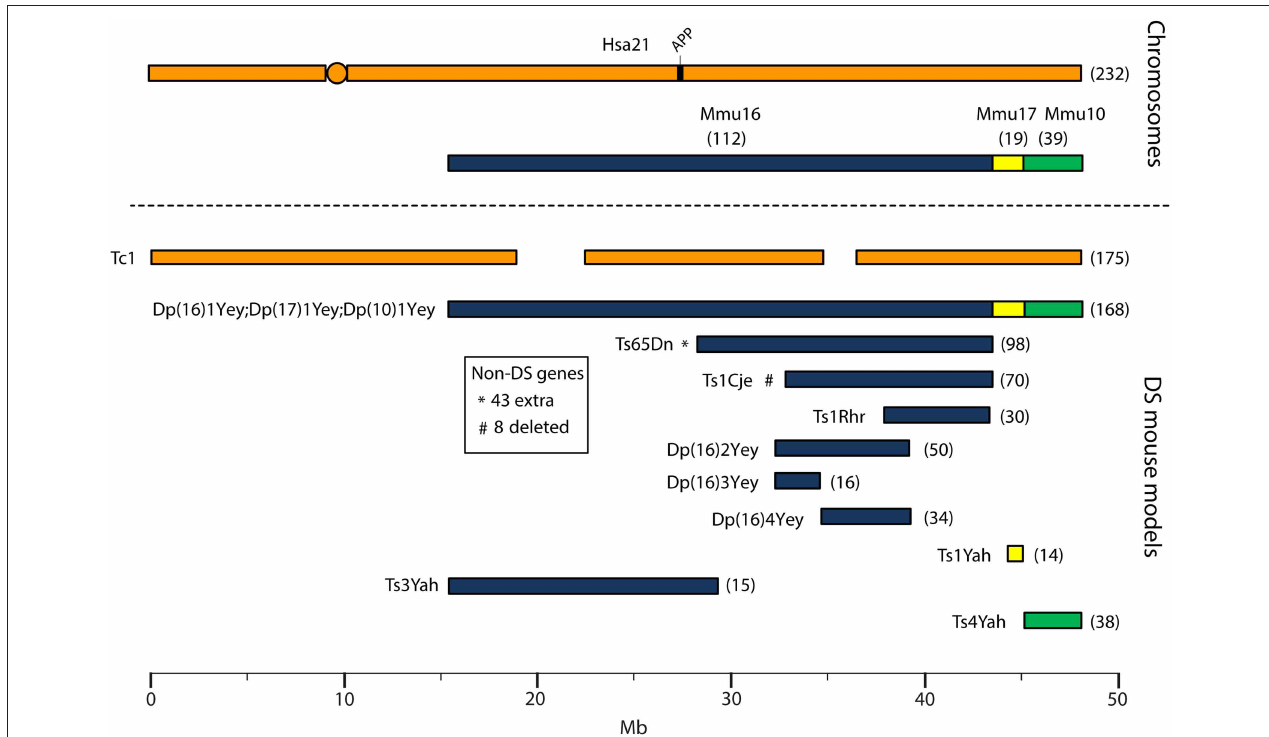
FIGURE 1 | Human chromosome 21 (Hsa21), orthologous mouse chromosomes (Mmu), and key mouse models of Down syndrome. Diagram representing Hsa21 and its alignment with syntenic regions on Mmus 16, 17, and 10. The orange circle represents the human centromere and mouse models are color-coded and aligned according to the chromosomal segment for which they are trisomic. Numbers in brackets represent the number of protein-coding Hsa21 orthologous genes within each region or mouse model, according to Ensembl release 79 and the breakpoints published in papers referenced here. The Tc1 mouse is the only model which carries Hsa21, though genomic rearrangements and deletions (indicated by breaks in the chromosome) mean the mouse is functionally trisomic for only ∼ 75% of Hsa21 genes (Gribble et al., 2013). All other mouse models carry duplications of mouse orthologues. The Dp1(16)Yey;Dp1(17)Yey;Dp1(10)Yey (or Ts1Yey;Ts3Yey;Ts2Yey) mouse was generated by crossing together three partial trisomy models (Yu et al., 2010a) and spans the entirety of the Hsa21-syntenic regions. The Ts65Dn mouse (Davisson et al., 1993) contains a freely segregating segment of Mmu16, however it is also trisomic for 43 extra protein-coding genes on the centromeric section of Mmu17 that are not relevant to DS (indicated by an asterisk ( * ) and accompanying text box; Duchon et al., 2011; Reinholdt et al., 2011). The Ts1Cje mouse (Sago et al., 1998) also contains a monosomy of eight protein-coding genes on Mmu12, irrelevant to the DS phenotype (indicated by “#” and accompanying text box. Gene numbers are based on Ensembl release 79, compared to the original seven monosomic genes detailed in Duchon et al., 2011). Other mice are Ts1Rhr or Dp1(16)Rhr mice (Olson et al., 2004); Ts1Yah mice (Pereira et al., 2009); Ts3Yah (previously published as Ts2Yah; Brault et al., 2015); and Ts4Yah mice (previously published as Ts3Yah mice; Herault et al., 2009). Other useful examples of mouse models include the Ts43H model (not shown) which is partially trisomic for Mmu17 including some genes with ortholog on Hsa21 (Vacík et al., 2005). The scale is in megabase pairs